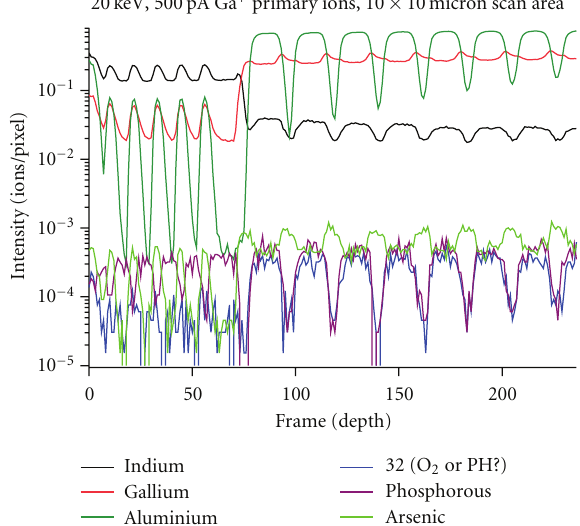
Figure 12: Depth profile of VECSEL 3/1 (see text). The well resolved aluminium features on the right hand side of the figure are each 100 nm in width and 100 nm apart. Similar results were achieved using a range of primary ion energies and currents. The modulation depth of the gallium signal is restricted because of the use of a gallium ion primary beam, which necessarily results in a strong gallium secondary ion background signal (due to secondary ions from implanted